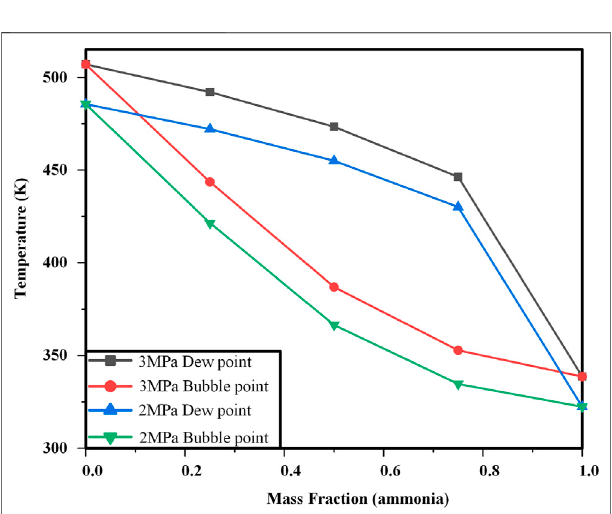
FIGURE 11 | Phase diagram of ammonia-water mixture at given